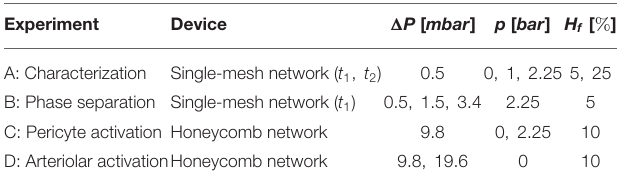
TABLE 1 | The table shows which device, perfusion pressure ( 1 P ), pressure in the chamber ( p ), and feeding hematocrit ( H f ) were defined for each experiment reported in this